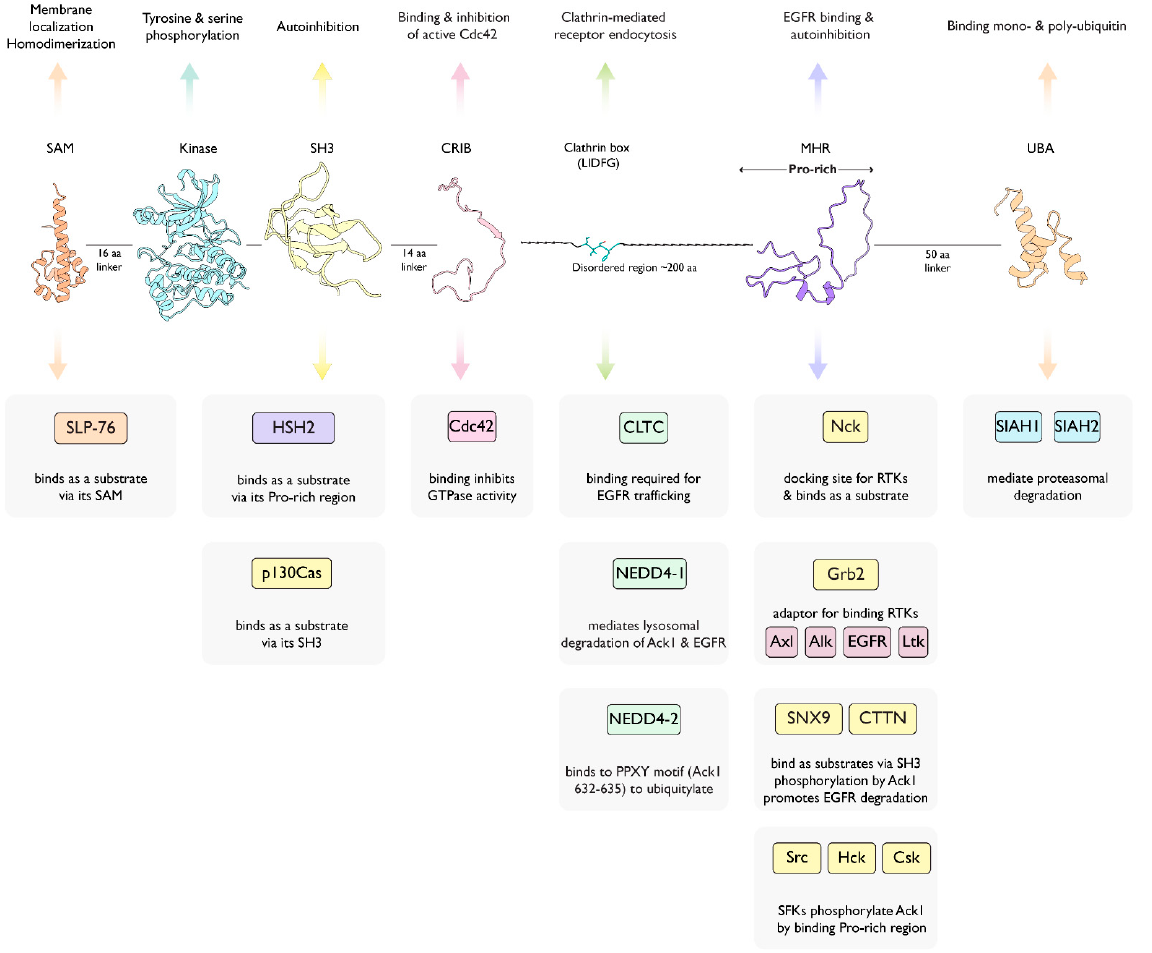
Figure 15. Graphical summary of known Ack1-protein interactions mapped onto a linear diagram of Ack1 domain structure. SAM, sterile alpha motif; SH3, Src homology 3; CRIB, Cdc42, and Rac- interactive binding; MHR, Mig6 homology region; UBA, ubiquitin-associated domain. Linker regions are designated disordered according to UniProtKB (Q07912) and AlphaFold prediction. Interacting proteins are color-coded according to the nature of the interaction such that the SH3-mediated are in yellow, the Pro-rich is purple, and the SAM-mediated is orange. Details of these interactions are as follows: SLP-76 [40], HSH2 [119], p130Cas [159], Cdc42 [134], Clathrin heavy chain (CLTC)